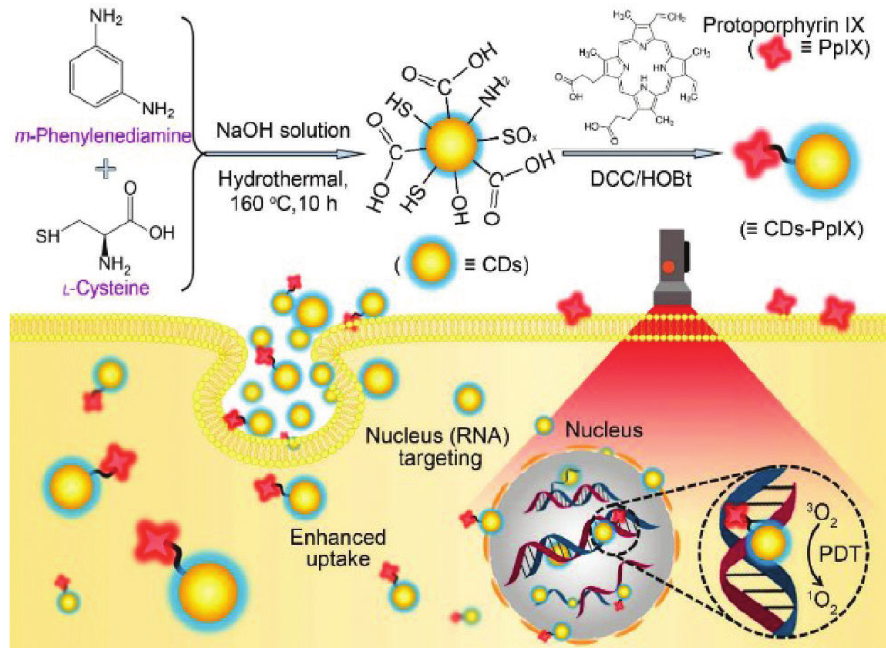
Figure 8: CDs synthesis schematic diagram and targeting the nucleolus imaging mechanism. Reprinted image with permission from Ref. [88], Copyright 2018, American Chemical